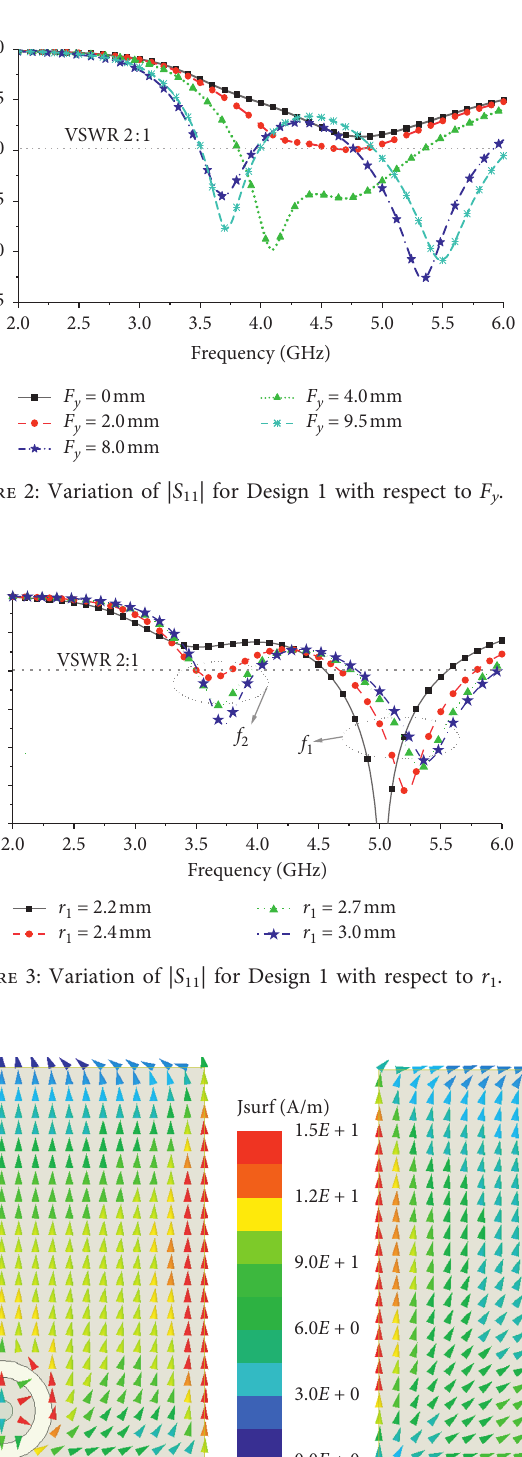
� 3.75GHz and (b) f � 2 1